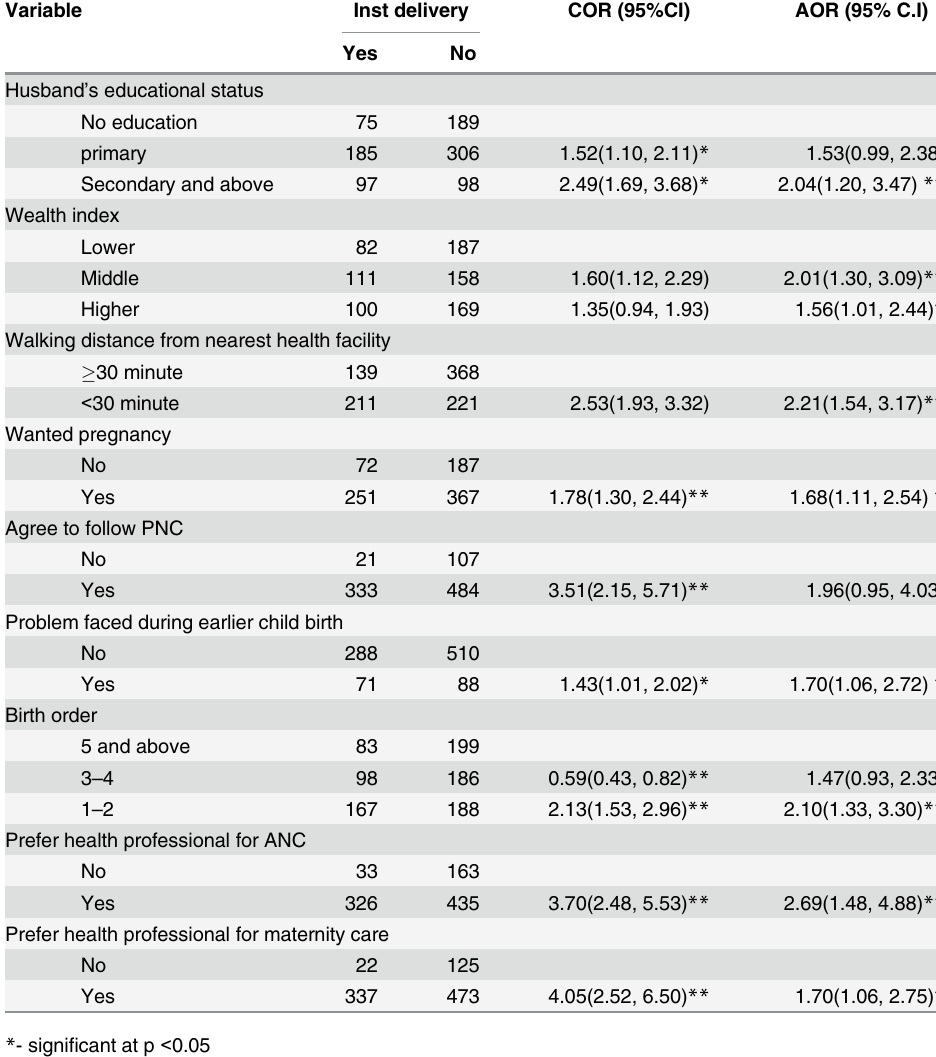
Table 3. Predictors of institutional deliveryservice utilization, Wolaita and Dawro Zone, Ethiopia,